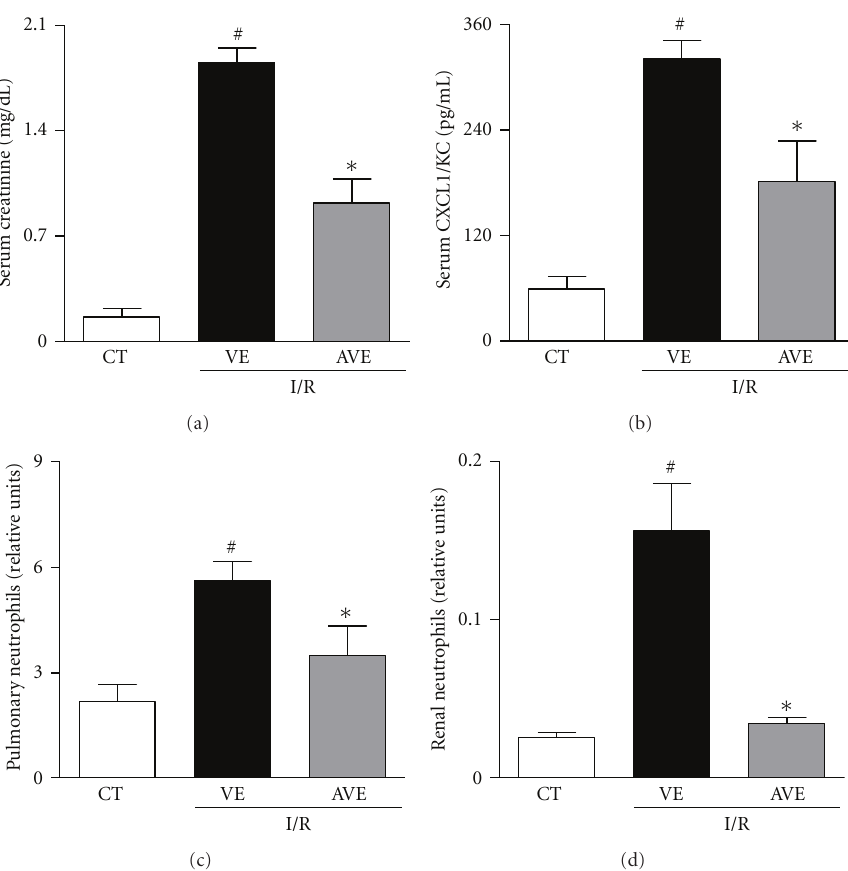
Figure 1: E ff ects of the treatment with AVE0991 in a model of renal ischemia and reperfusion in mice. AVE0991 (AVE, 9.0 mg/kg) or vehicle (VE; 10mMKOH in 0.9% NaCl) was given immediately after ischemia and 12h after reperfusion. All analyses were performed at 24h after reperfusion. Serum creatinine (a), number of neutrophils in blood (b), levels of CXCL1/KC (c), and relative number of neutrophils in renal tissue (d) are shown as the mean ± SEM from six mice per group. ∗ P < 0 . 05 when compared with VE-treated animals; # P < 0 . 05 when compared with sham-operated animals (CT,